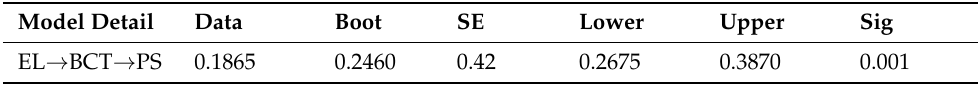
Table 5. Mediating impact of Blockchain Technology between E-Learning and Privacy and Security.